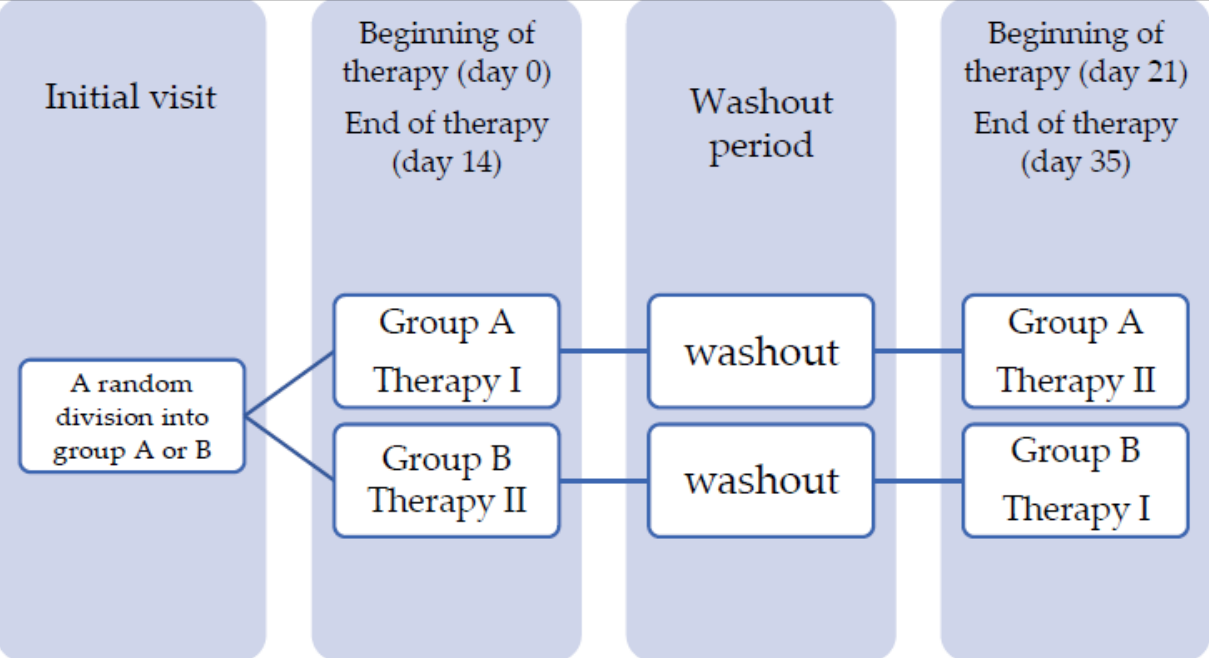
Figure 2. The study design.